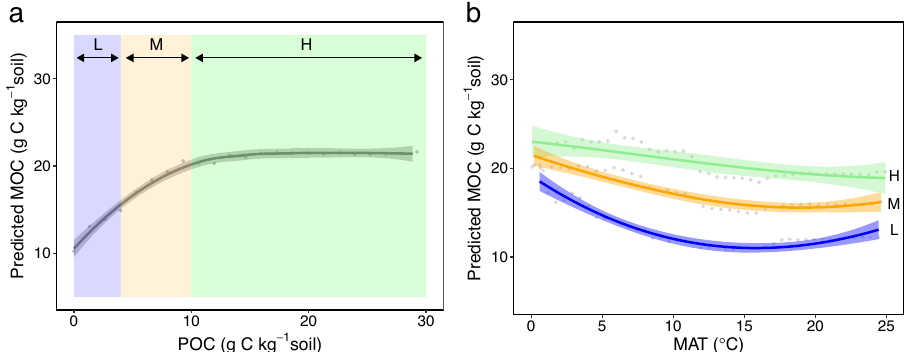
Fig. 3 Data-driven predictive relationships of mineral-associated organic carbon as a function of individual controlling factors and interactions. A random forest model was used to disentangle the signi fi cance and emergent relationships of individual covariates, using partial dependence relationships that describe the marginal effect of each variable on the predicted mineral-associated carbon (MOC) response (see “ Methods ” ). a Predicted MOC as a function of particulate organic C (POC). For each plot, the points show random forest model predictions; best fi t lines and shading show 99% con fi dence intervals on each trend. b Predicted MOC as a function of mean annual temperature (MAT), conditional on three distinct subsets of POC — namely, low (L), medium (M), and high (H) POC corresponding to unsaturated to saturated regimes. The breakpoints were selected as the median and third quartile of the POC distribution, which also correspond to approximate saturation thresholds in the partial dependence plot of POC